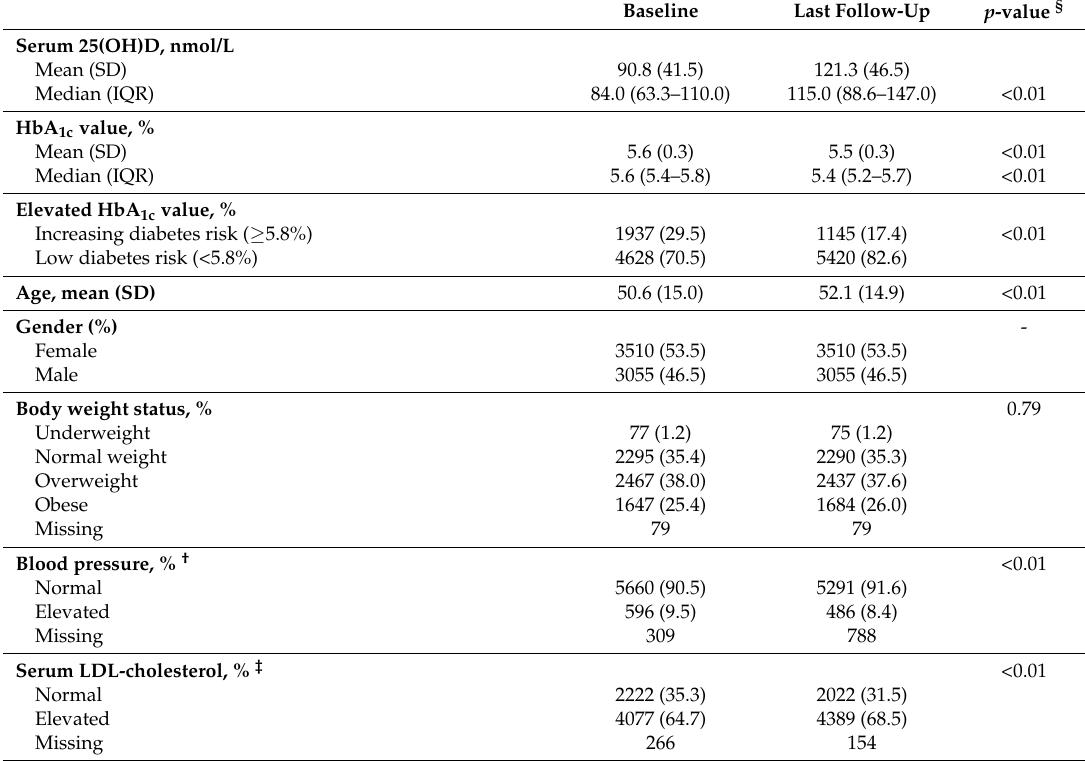
Table 1. Baseline and follow-up characteristics of 6565 study